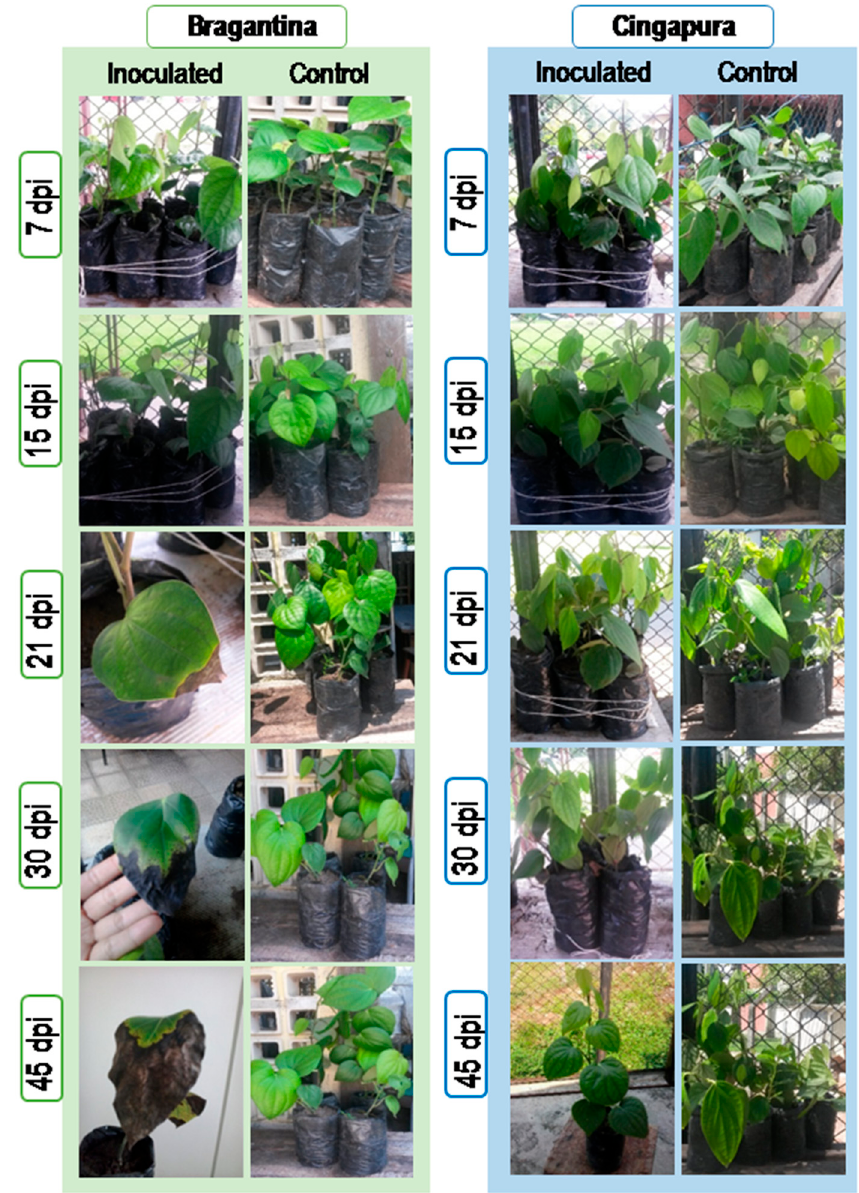
Figure 1. Visual evaluation of Fusariosis symptoms in P. nigrum cultivars during inoculation by F. solani f. sp. piperis . dpi: days post infection.